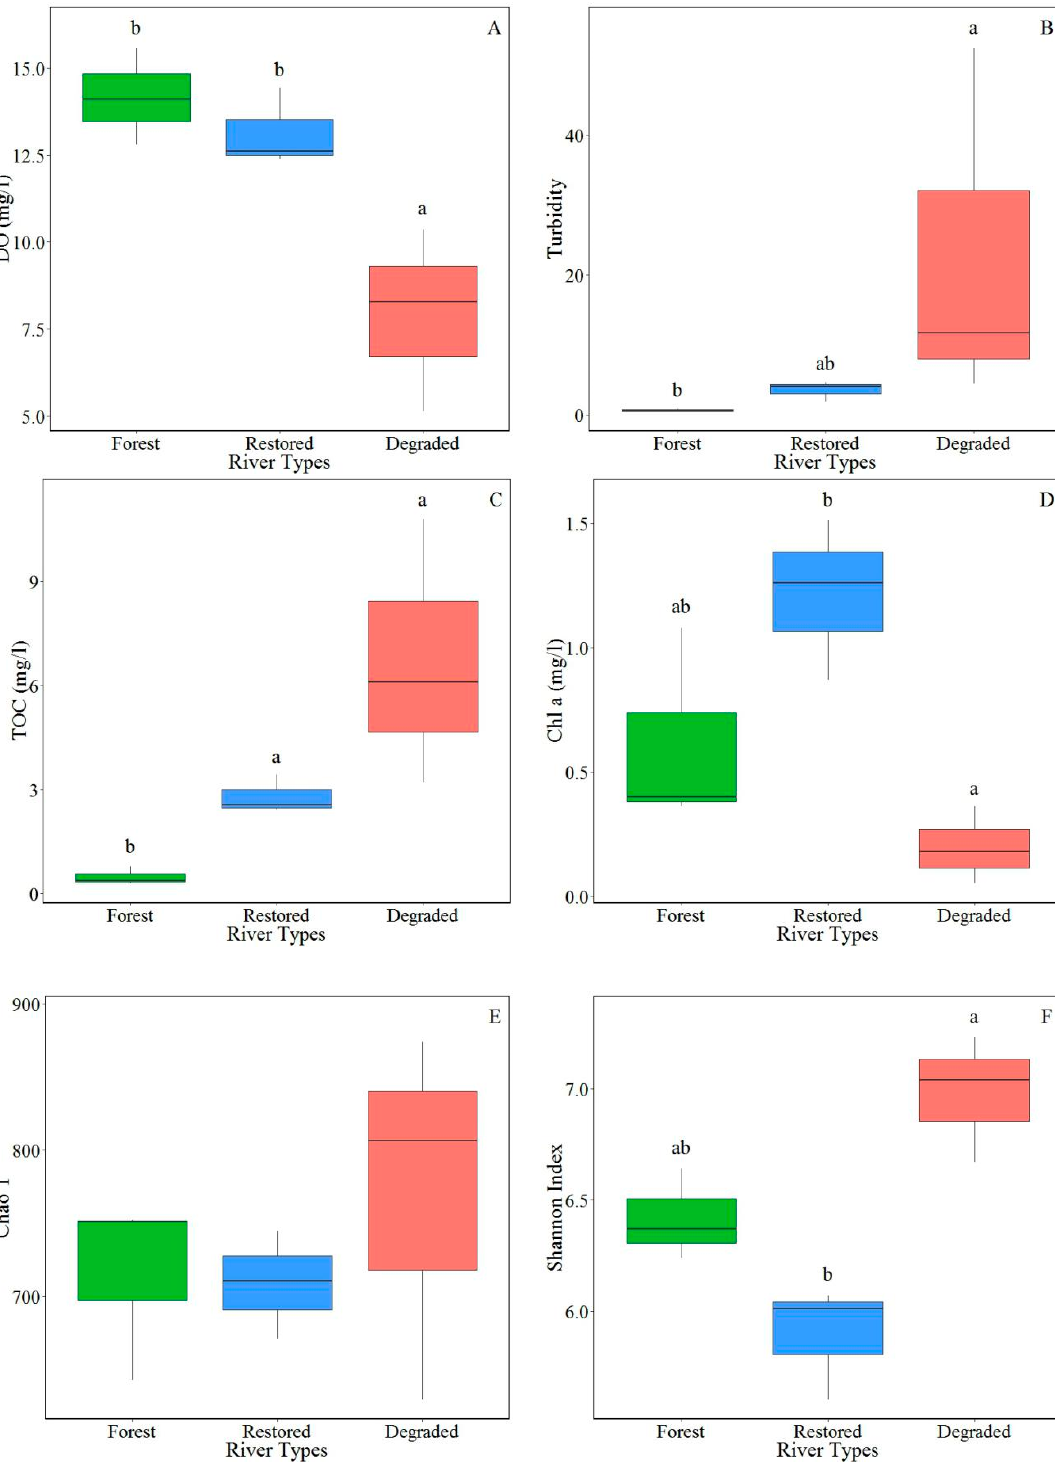
Figure 2. Boxplots representing the variance of physico-chemical parameters ( A ) dissolved oxygen (DO), ( B ) turbidity, ( C ) total organic carbon (TOC), ( D ) Chl- a and bacterial α -diversity ( E ) bacterial richness (Chao 1 Index), ( F ) bacterial diversity (Shannon Index) in forested, restored and degraded rivers within the Anji City Region, PRC. Black line: median value; box: quartile interval; whiskers: minimum and maximum value. Di ff erent lowercase letters indicate the significant di ff erence observed at the p = 0.05 level.